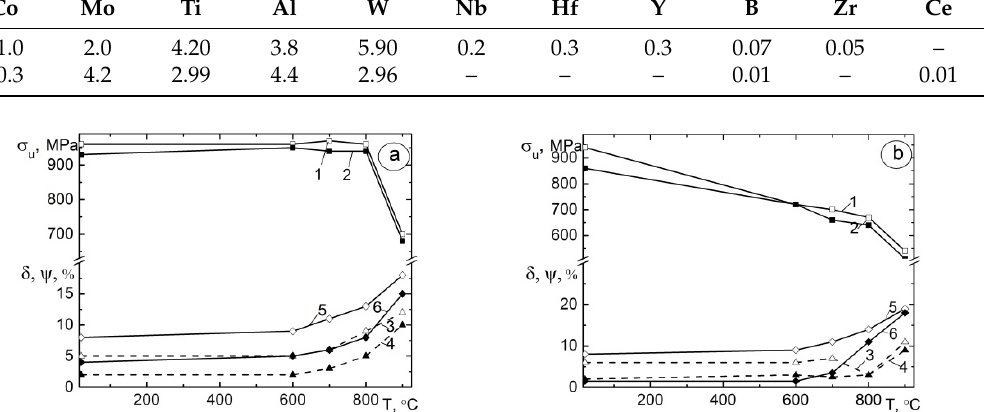
Figure 5. Temperature dependences of the ultimate strength σ u (1, 2), relative elongation δ (3, 4) and reduce of area ψ (5, 6) of CM-88Y ( a ) and ZhS3DK ( b ) alloys in air (1, 3, 5) and water at a pressure of 30 MPa (2, 4, 6).